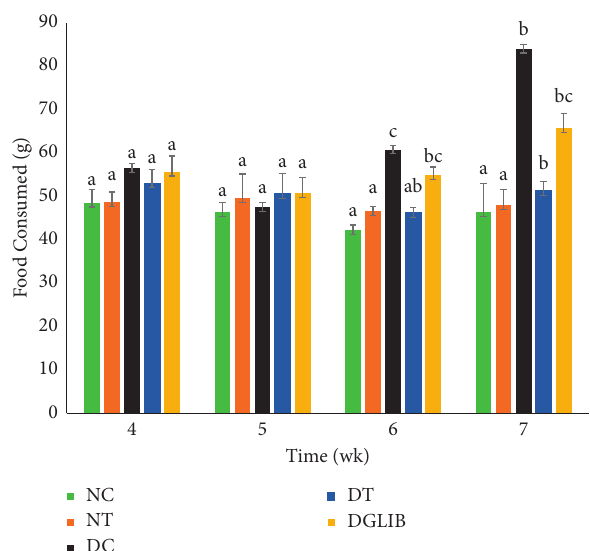
Figure 2: Average daily food consumption of diabetic and euglycaemic S-D rats in the last four weeks of the study. Data are expressed as mean ± standard error of the mean and analysed